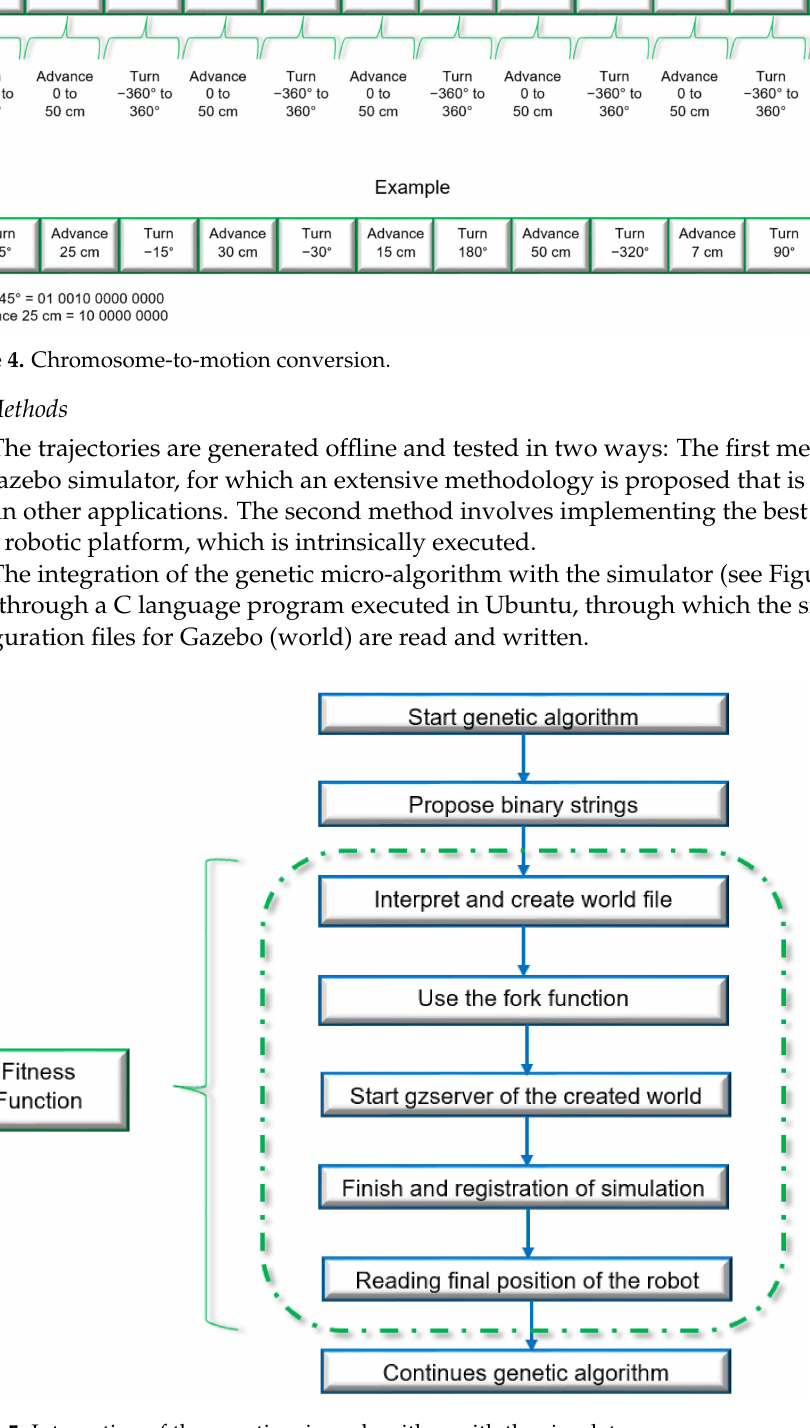
Figure 5. Integration of the genetic micro-algorithm with the